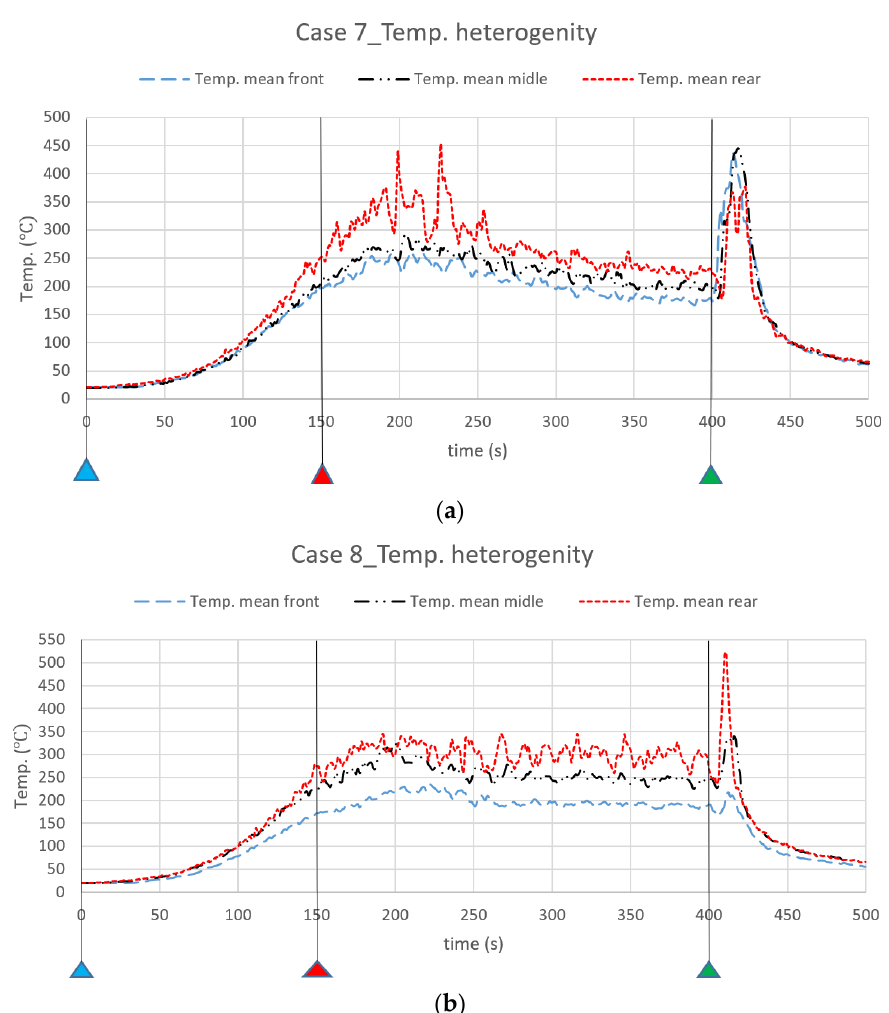
Figure 8. ( a ) Case 7 without partition wall or flashover/backdraft at 411 s; ( b ) case 8 with partition wall and no flashover/backdraft.